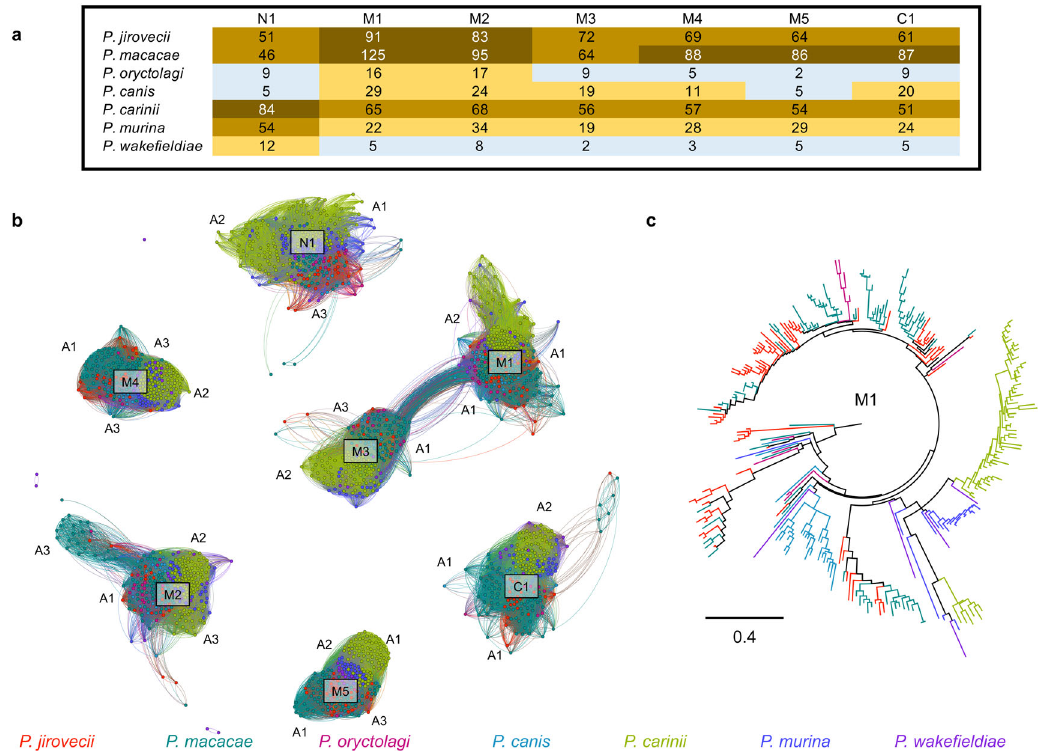
Fig. 5 Evolution of Msg cysteine-rich protein domains in Pneumocystis . a Heatmap showing the distribution of Msg domains in each Pneumocystis species. The color change from blue-orange-brown indicates an increase in the number of domains. b Graphical representation of protein similarity between domains, which highlights that the domains were present in the most recent common ancester and were maintained other than perhaps domains M1 and M3. Domains are clustered by a minimum BLASTp cutoff of 70% protein identity. c Maximum likelihood tree of the M1 domain. In both panels b and c , domains are color-coded by species as shown at the